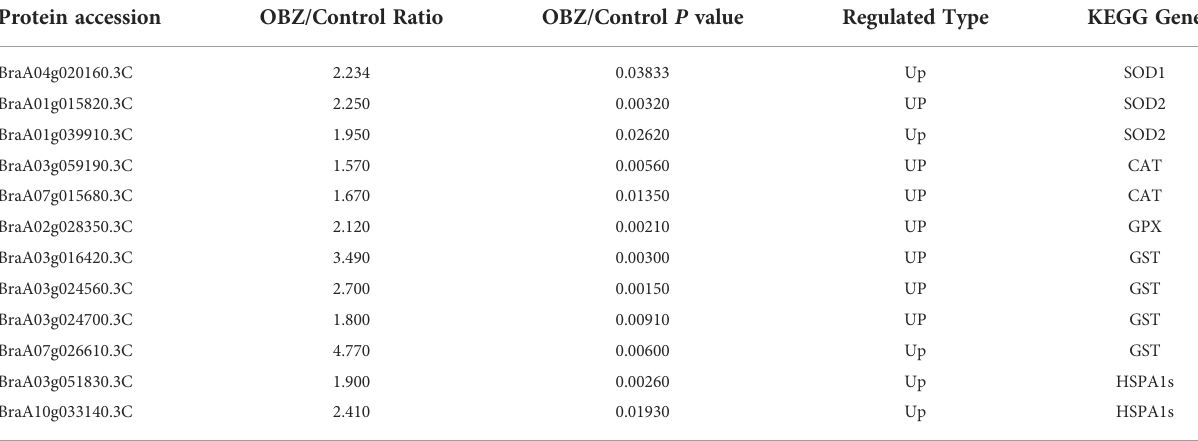
TABLE 1 Differentially modi fi ed sites (modi fi ed proteins) for antioxidant system. Protein accession OBZ/Control Ratio OBZ/Control P value Regulated Type KEGG